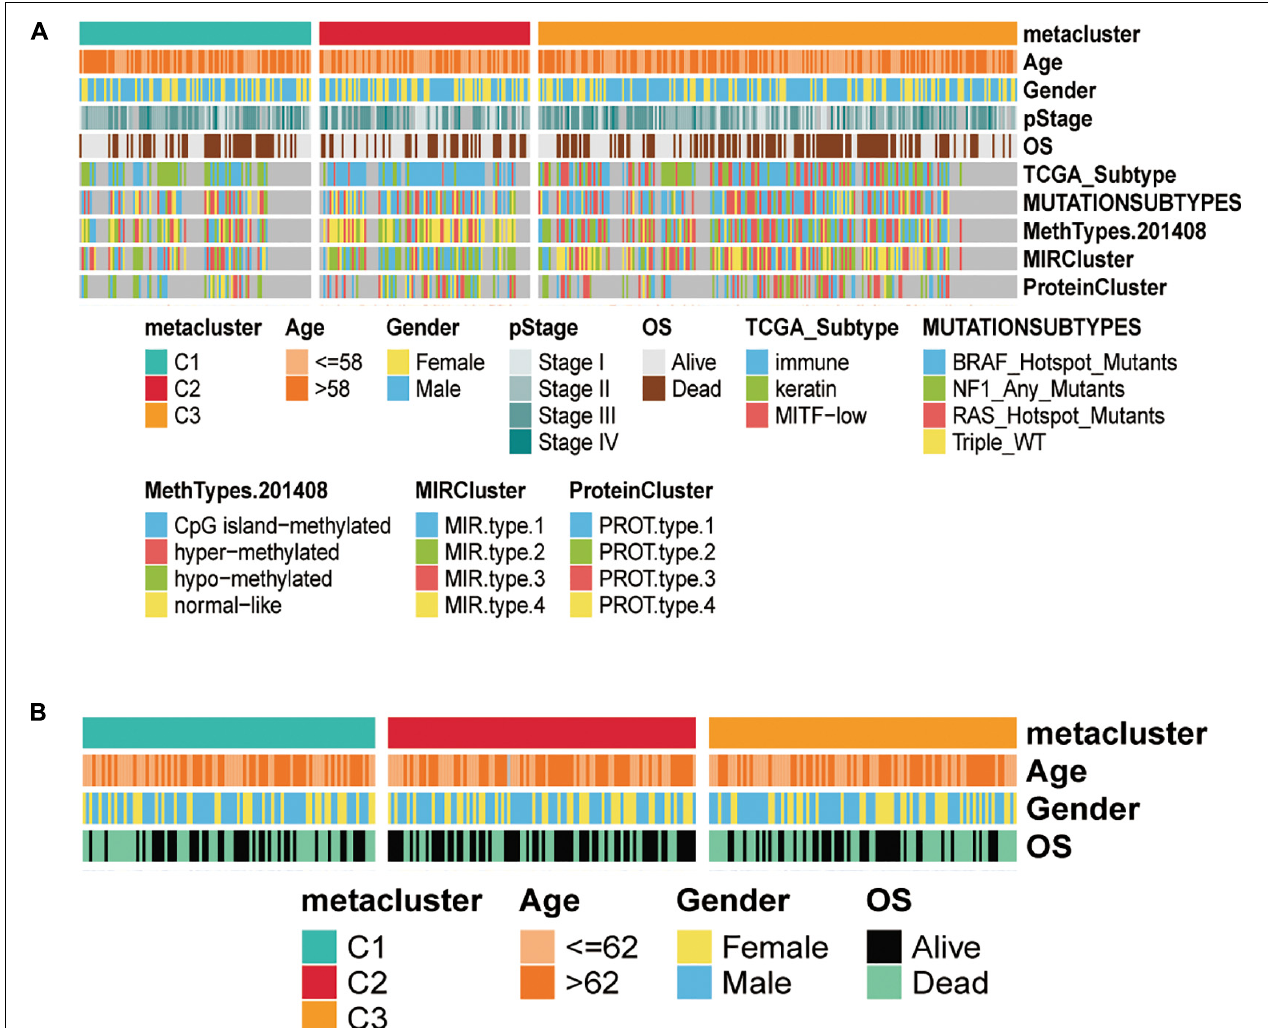
FIGURE 4 | Clinical characteristics of three subtypes in the TCGA-SKCM and GSE14520 cohorts. (A) Correlation of C1, C2, and C3 subtypes with clinical features and previous SKCM subtypes in the TCGA cohort. (B) Correlation of our classification with clinical features in the validation GSE14520 set